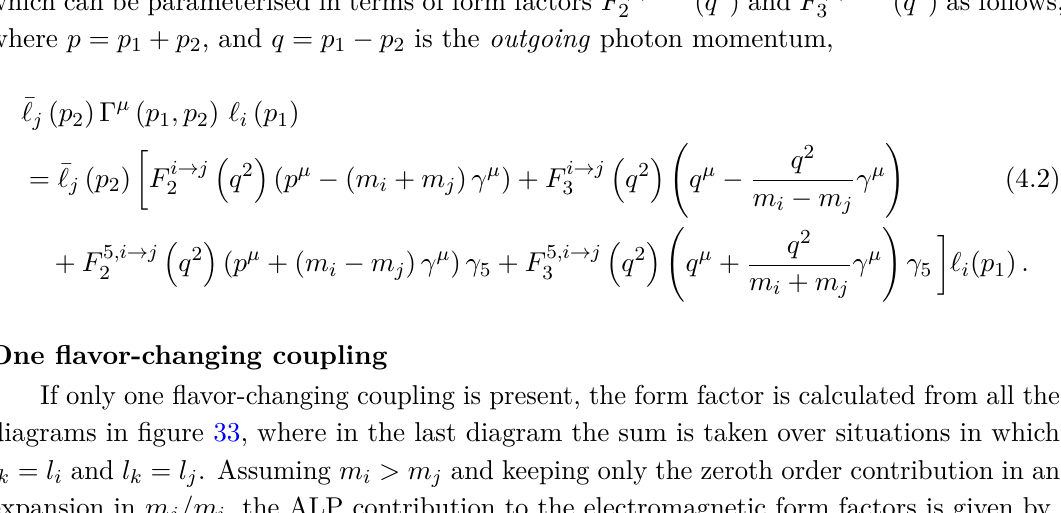
which can be parameterised in terms of form factors F (5) ,i → j